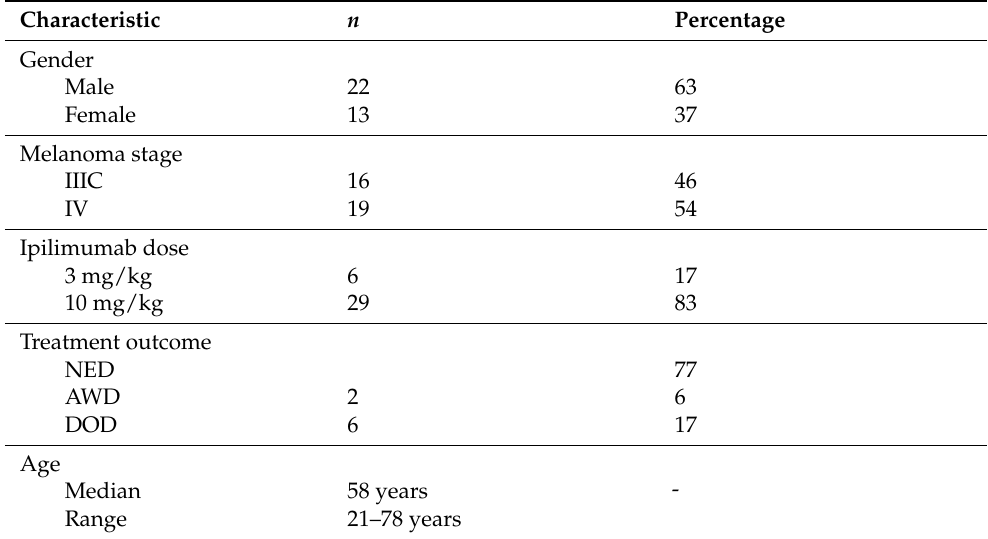
Table 1. Patient characteristics ( n =